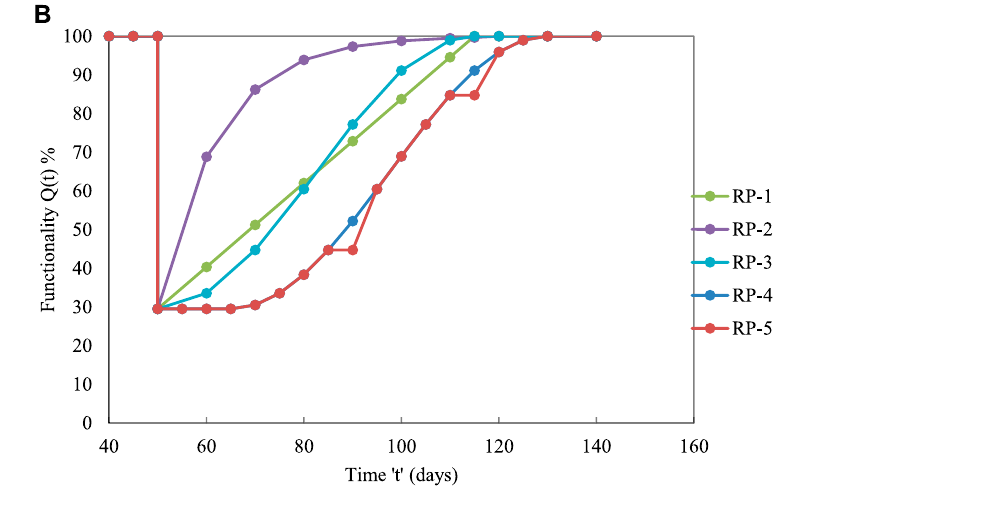
Frontiers in Built